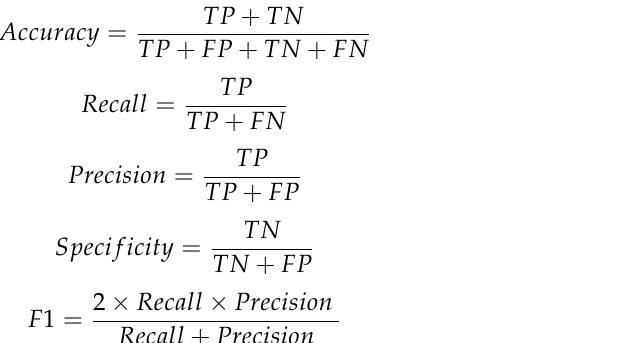
Figure 13. The curve of iterative convergence. The accuracy on the training set is shown by the black line, while the accuracy on the test set is represented by the red line. Table 5. Validation set contains label table.